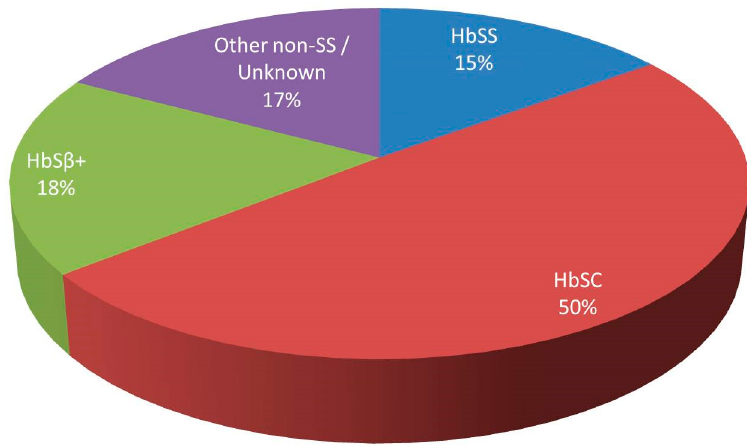
Figure 1. Distribution of fat embolism syndrome cases by sickle cell genotype.